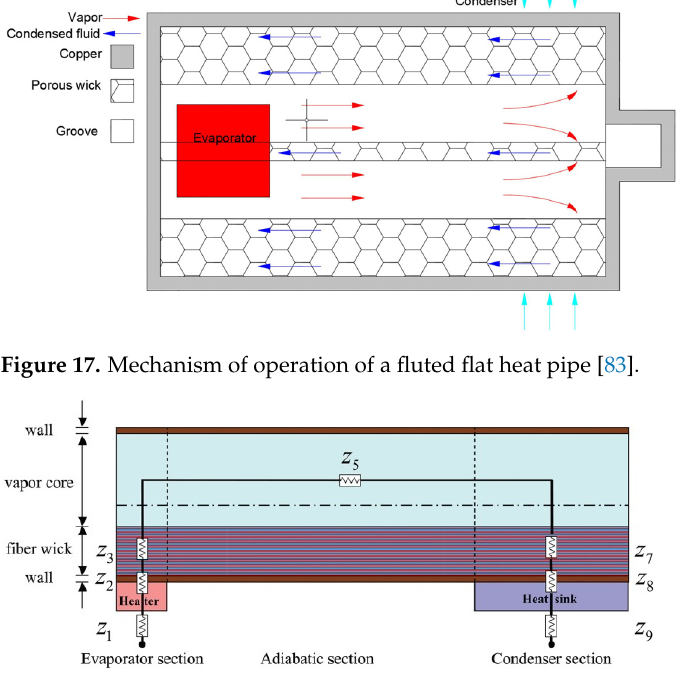
Figure 18. Traditional heat pipe equivalent thermal resistance network [84].